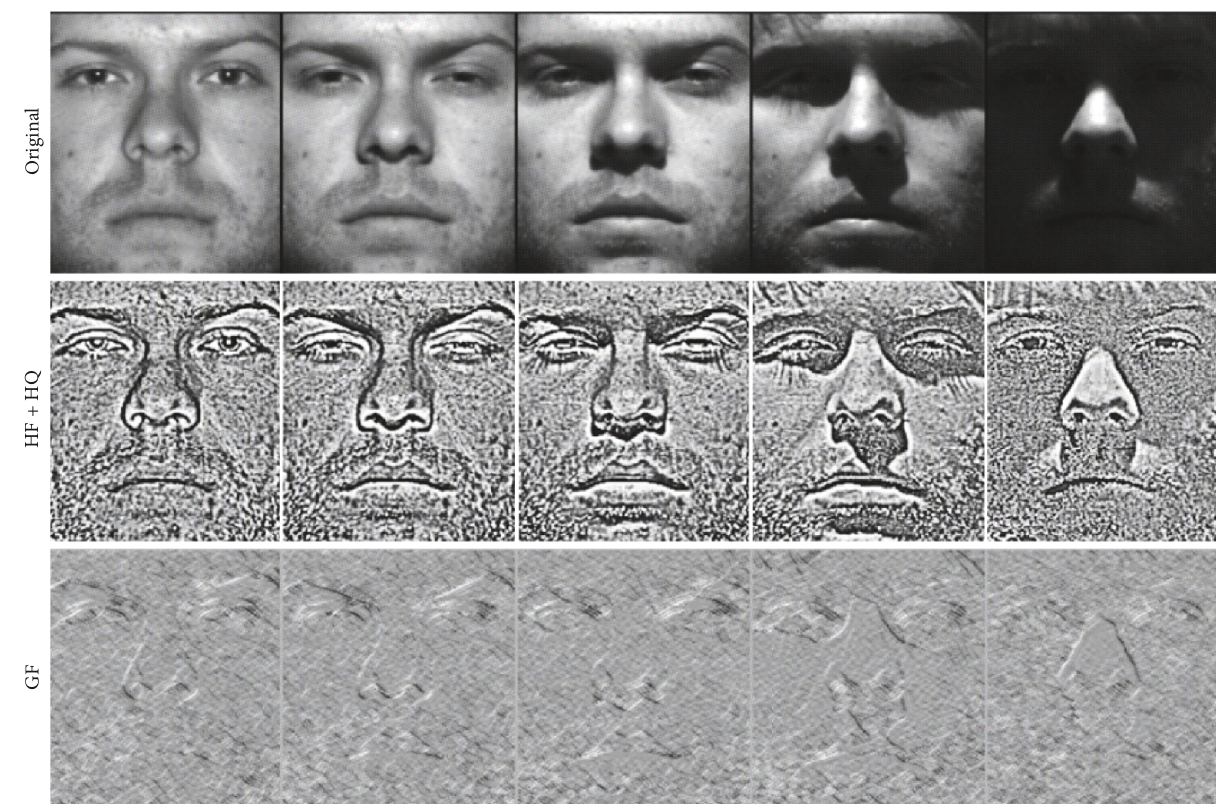
Figure 2: Examples of the HF + HQ processed images and the extracted illumination invariant.